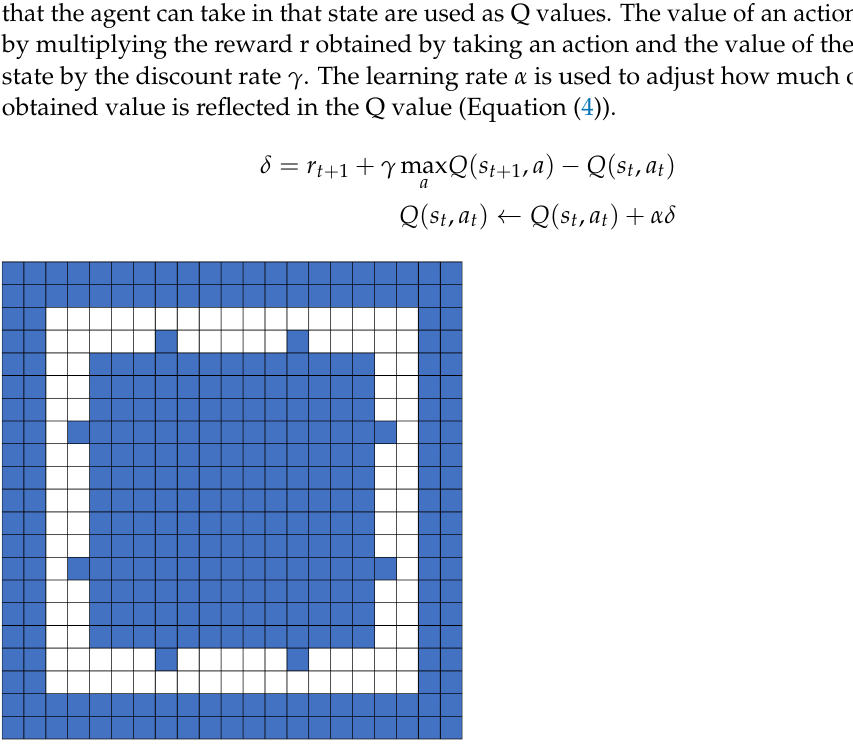
Figure 1. Corridor in which agents move around.